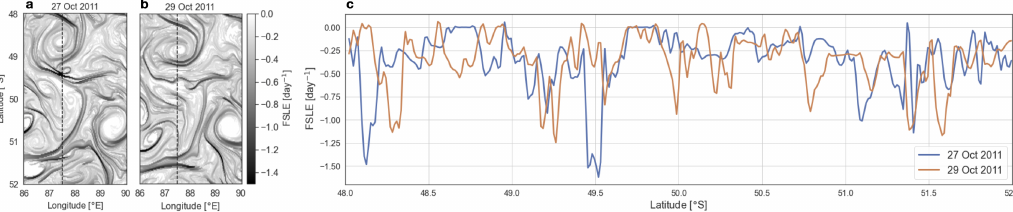
Figure 15. ( a ) FSLE filt at 39 m on 27 October 2011 00:00:00 UTC. ( b ) FSLE filt at 39 m on 29 October 2011 00:00:00 UTC. The dashed gray line at 87.5 ◦ E corresponds to the section in ( c ). ( c ) Meridional profile of FSLE filt at 39 m and 87.5 ◦ E on 27 October 2011 00:00:00 UTC, 2011 (blue line) and 29 October 2011 00:00:00 UTC (orange